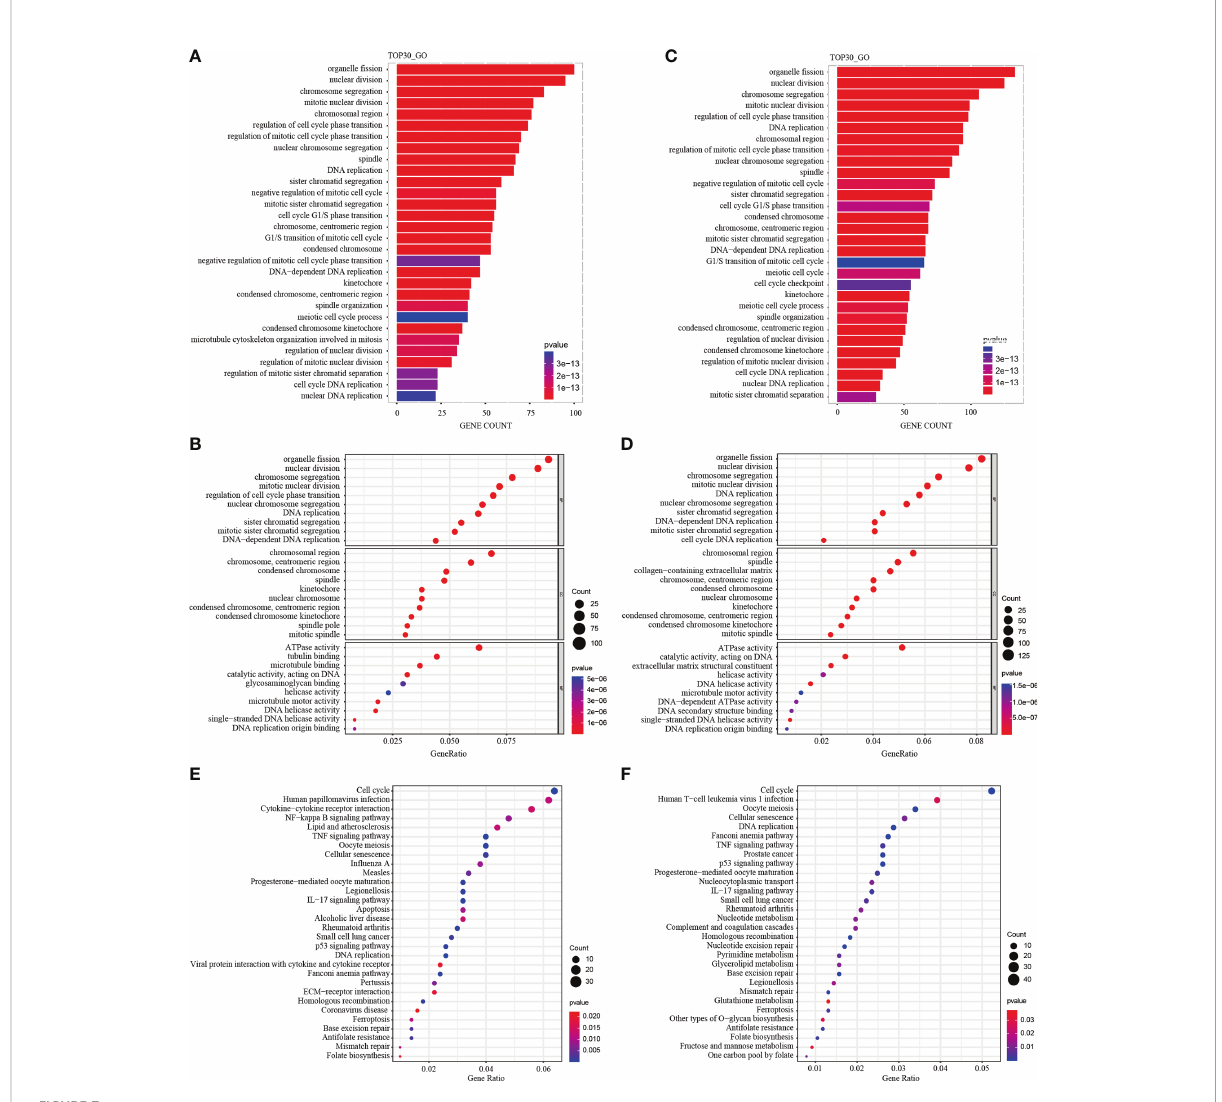
FIGURE 7 GO functional and KEGG pathway enrichment analysis of differentially expressed genes (DEGs) in M1CM or M2CM treated NPCs. The GO terms and KEGG pathway names are shown on the y-axis. Top 30 most signi fi cantly enriched GO terms of NPCs treated with M1CM (A) or M2CM (C) are displayed in a GO functional enrichment strip map. The length of the bars on the x-axis represents the gene counts, and the GO terms are shown on the y-axis. The bubble chart of the top 10 most signi fi cantly enriched GO terms of NPCs treated with M1CM (B) or M2CM (D) are displayed in terms of BPs, MF and CCs respectively. The x-axis represents the gene proportion in the annotation pathway, and the y-axis represents the GO terms. The color is determined by the P value, and the size is determined by the number of genes in the annotation pathway. (E, F) KEGG function enrichment bubble chart. The x-axis represents the ratio of genes in the annotation pathway, and the y-axis represents the KEGG pathway, the color is determined by the P value, and the size is determined by the number of genes in the annotation